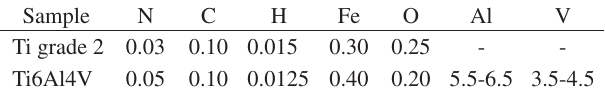
Table 1. Composition/wt. (%) of Ti and Ti6Al4V alloy (maximum values) reported by the supplier. Sample